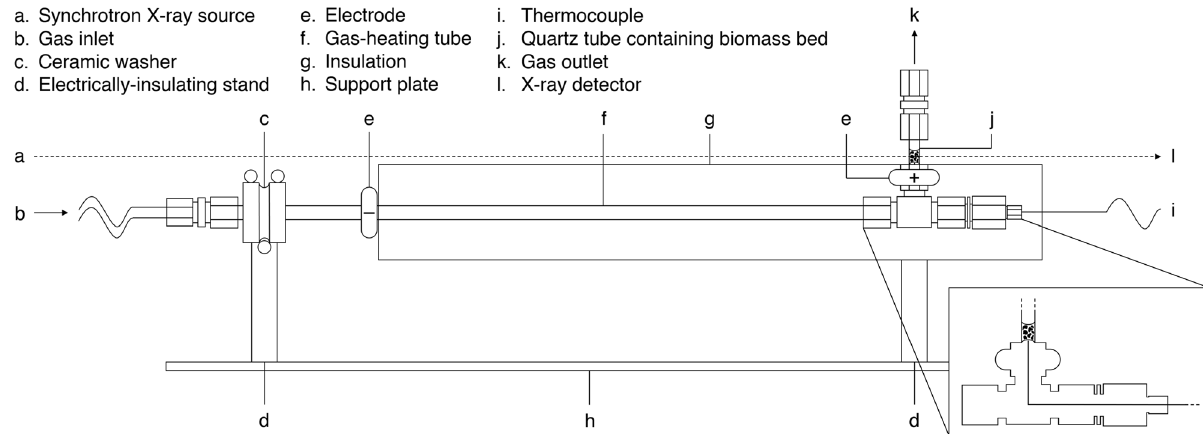
Figure 8. Schematic of the novel purpose-built reactor used to acquire in-situ radiographs.